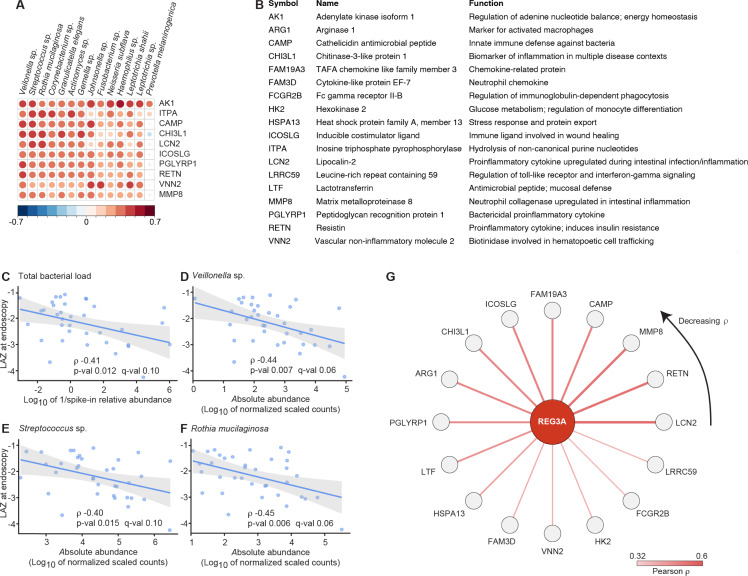
Correlations between components of the duodenal proteome, the absolute abundances of
duodenal bacterial taxa and stunting.(A) The top 10 positive correlations between members of the 14 core taxa
and duodenal proteins. The size and color of the circle represents the magnitude of
the correlation (larger circle and darker color indicates stronger correlation).
(B) Annotations of proteins shown in panels A and G. (C-F)
Total duodenal bacterial load, and the abundances of the three organisms most
positively correlated with duodenal inflammatory proteins are significantly negatively
correlated with LAZ. The least-squares regression line is depicted in blue while
shaded regions denote 95% confidence bands. (G) Star network of
correlations between plasma REG3A and core taxa-associated duodenal proteins. As
indicated by the color key, edge transparency/color corresponds to correlation
strength (darker edges denote a stronger correlation). The duodenal protein with the
strongest correlation, lipocalin-2 (LCN-2), is indicated by the tail of the arrowhead
at 3 o’clock; duodenal proteins with progressively weaker correlations with
REG3A are distributed in a counter-clockwise fashion from this position.